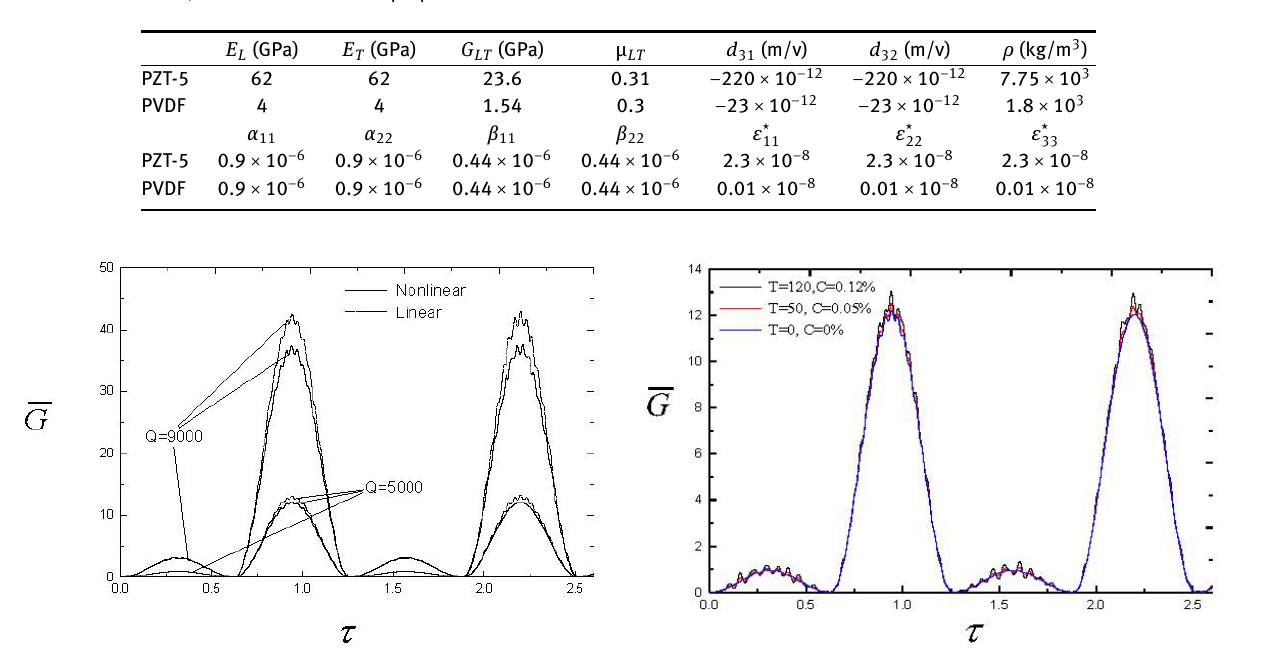
Figure 4. Effect of geometric nonlinear on energy release rate of delaminated piezoelectric shell